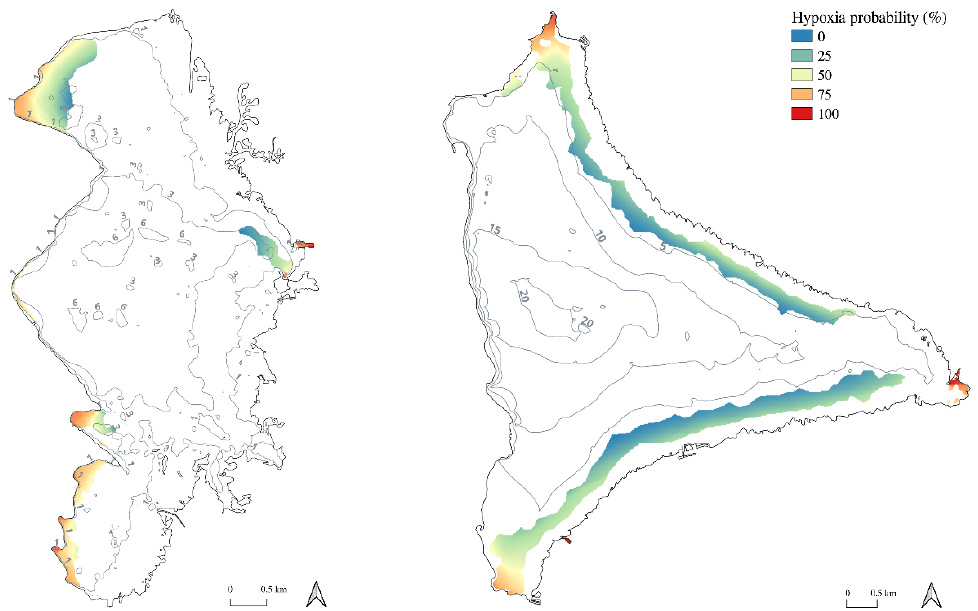
Figure 5. Hypoxia risk maps calculated for one year in densely vegetated areas of LAC Lake (on the left ) and PAR Lake (on the right ). Lakes bathymetry is also reported.